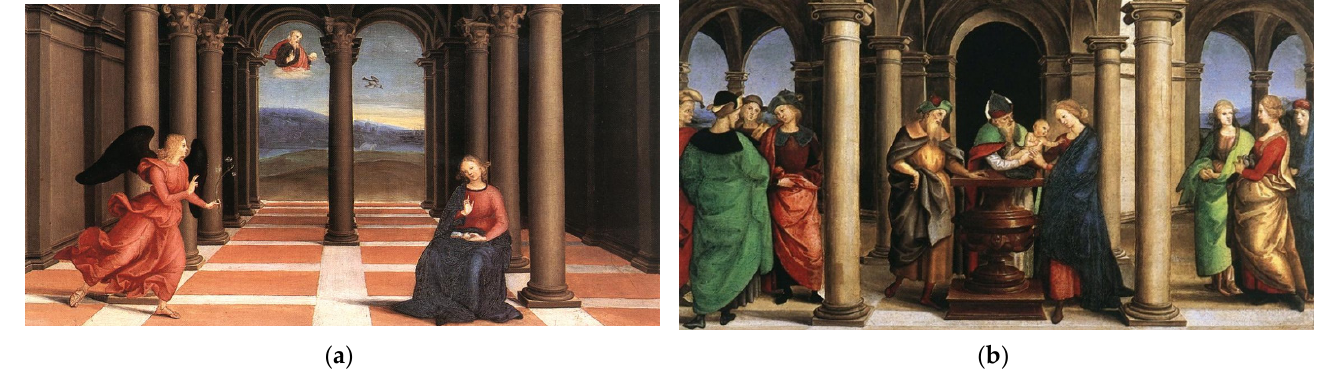
Figure 6. Raffaello, Pala degli Oddi, 1503, Vatican Art Gallery, Rome: ( a ) The Annunciation; ( b ) The Presentation.